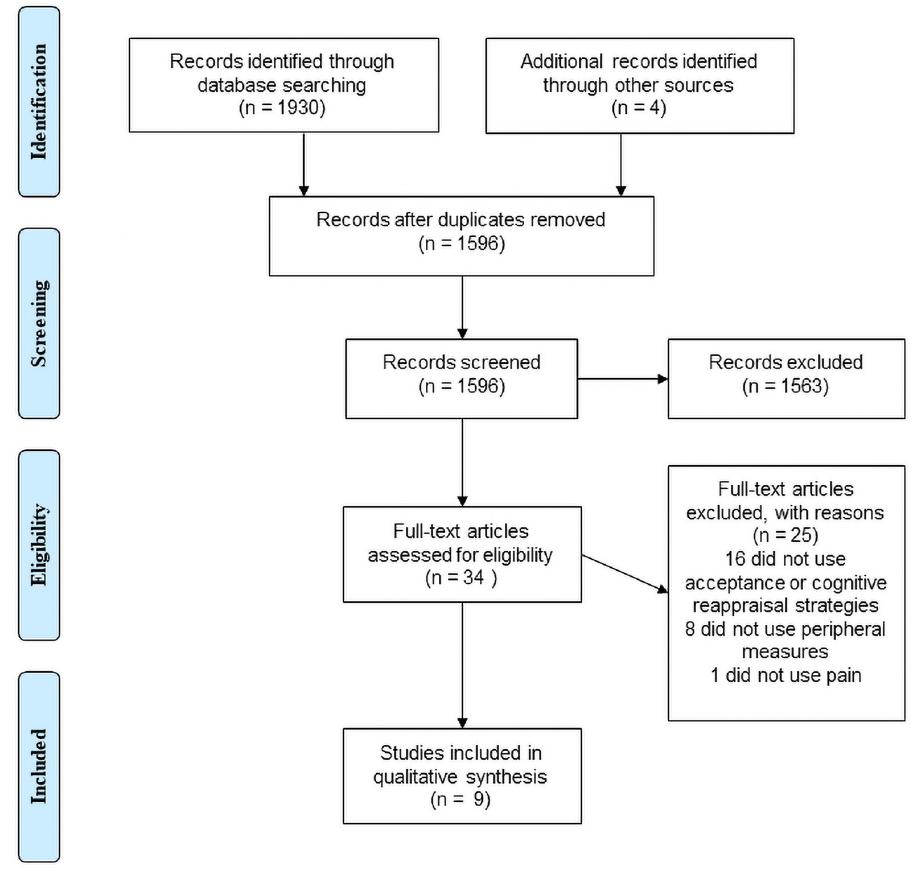
Fig 1. PRISMA flow